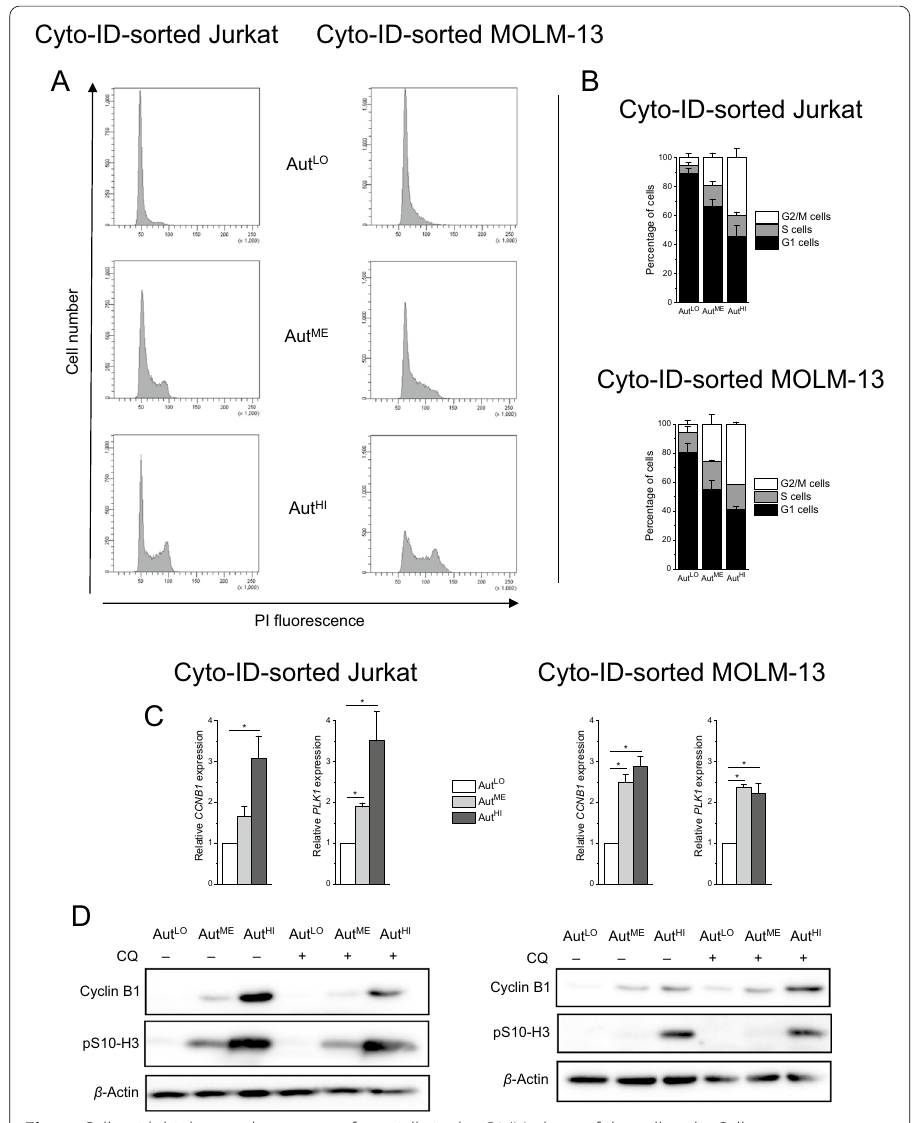
Fig. 7 Cells with high autophagy are preferentially in the G2/M phase of the cell cycle. Cells were flow‑cytometrically sorted on the basis of their Cyto‑ID fluorescence intensity into subpopulations with low, medium, and high Cyto‑ID fluorescence (Aut LO , Aut ME , and Aut HI , respectively). A, B Cells were fixed in ethanol approximately 1 h after sorting. Cell cycle phases were determined by flow‑cytometric analysis of PI‑stained ethanol‑fixed cells. A Representative histograms of cell populations. B Quantification of cell cycle phases. C RNA was prepared approximately 1 h after sorting. mRNA expression levels were determined by real‑time RT‑PCR and normalized to B2M expression levels. Mean SEM of three independent measurements ± is shown (* P < 0.05). D Representative immunoblots of lysates from sorted cells. Lysates were prepared after 1‑h cultivation of sorted cells in the absence or presence of 10 µM CQ. The loading controls are the same as in Fig. 5A since LC3B, cyclin B1, pS10‑H3, and β‑actin were detected on the same